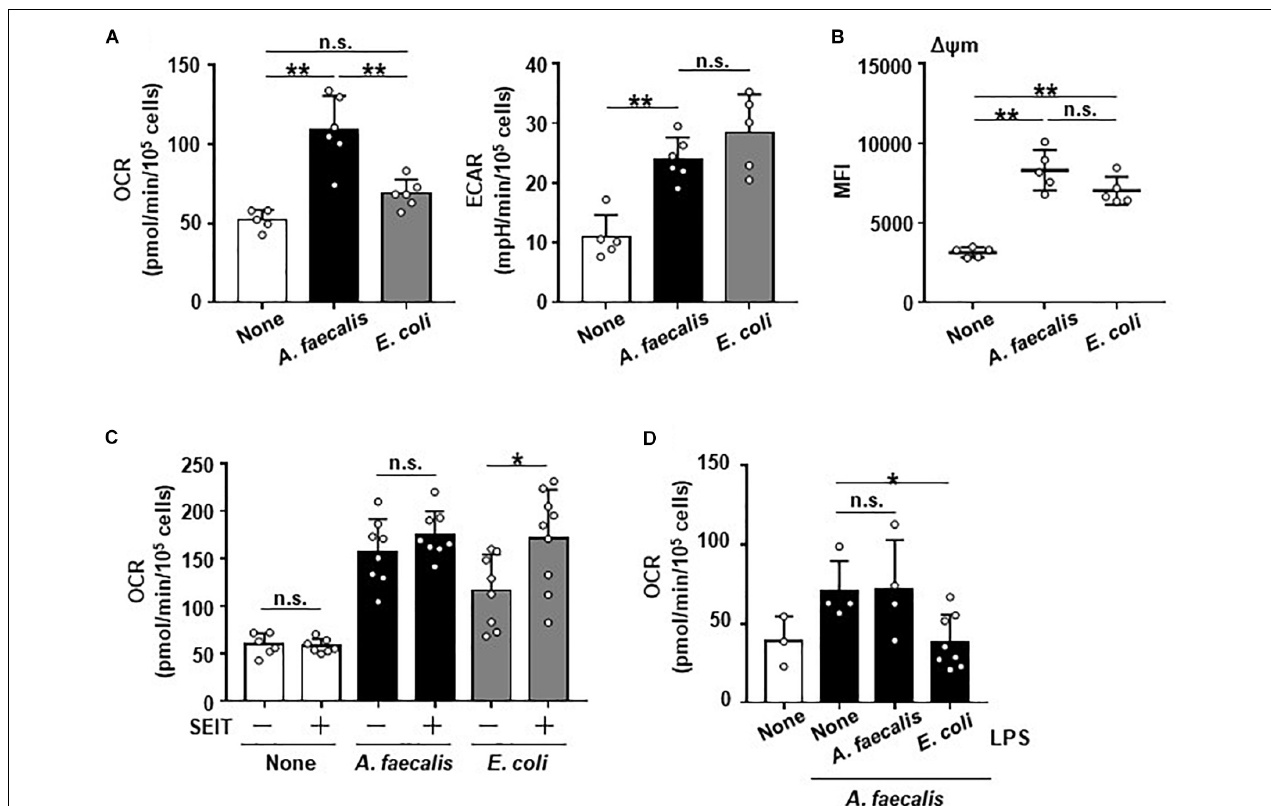
FIGURE 3 | Unique alteration of the energy metabolism of DCs induced by A. faecalis. BMDCs were co-cultured without (None) or with live A. faecalis and E. coli at 10 MOI for 24 h. (A) After the co-culture, the basal oxygen consumption rate (OCR) and extracellular acidification rate (ECAR) were measured by using a flux analyzer. (B) After the co-culture, BMDCs were collected and stained with tetramethylrhodamine methyl ester and analyzed by flow cytometry to measure mitochondrial membrane potential ( (cid:49) ψ m). (C) BMDCs were co-cultured without (None) or with live A. faecalis or E. coli at 10 MOI for 24 h in the absence or presence of the iNOS inhibitor SEIT and then OCR was measured by flux analyzer. (D) BMDCs were co-cultured without (None) or with live A. faecalis at 10 MOI for 24 h in the absence (None) or presence of A. faecalis LPS or E. coli LPS at 0.1 µ g/ml and OCR was measured by flux analyzer. The results shown in (A,C,D) are combined from two independent experiment. The result shown in (B) is representative of two independent experiments. * P < 0.05; ** P < 0.01; n.s., not significant, which is described in Materials and